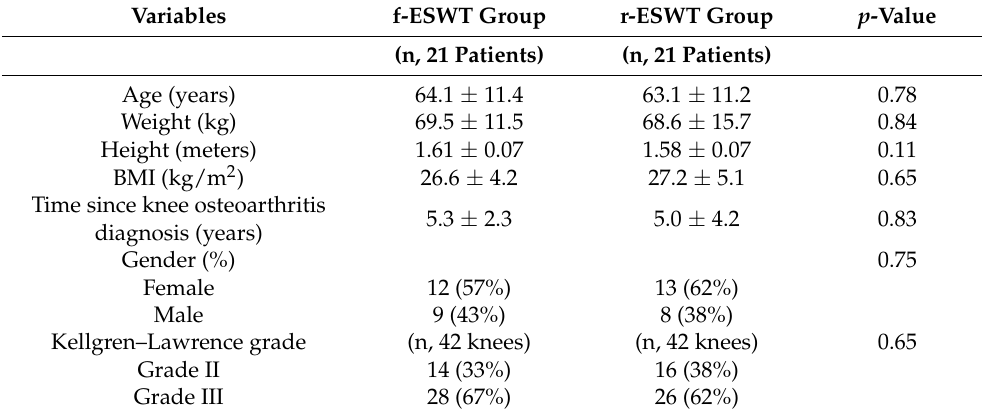
Table 1. Baseline demographic and clinical characteristics of participants by treatment group.